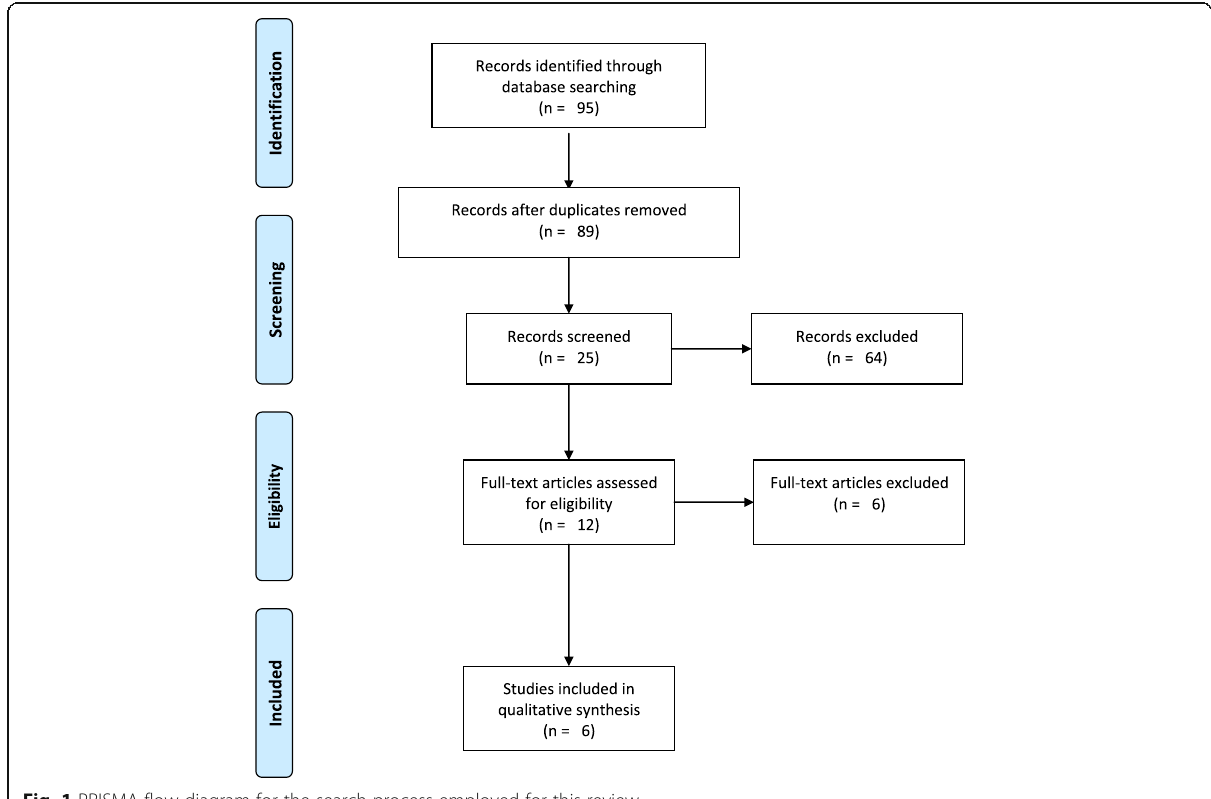
Fig. 1 PRISMA flow diagram for the search process employed for this